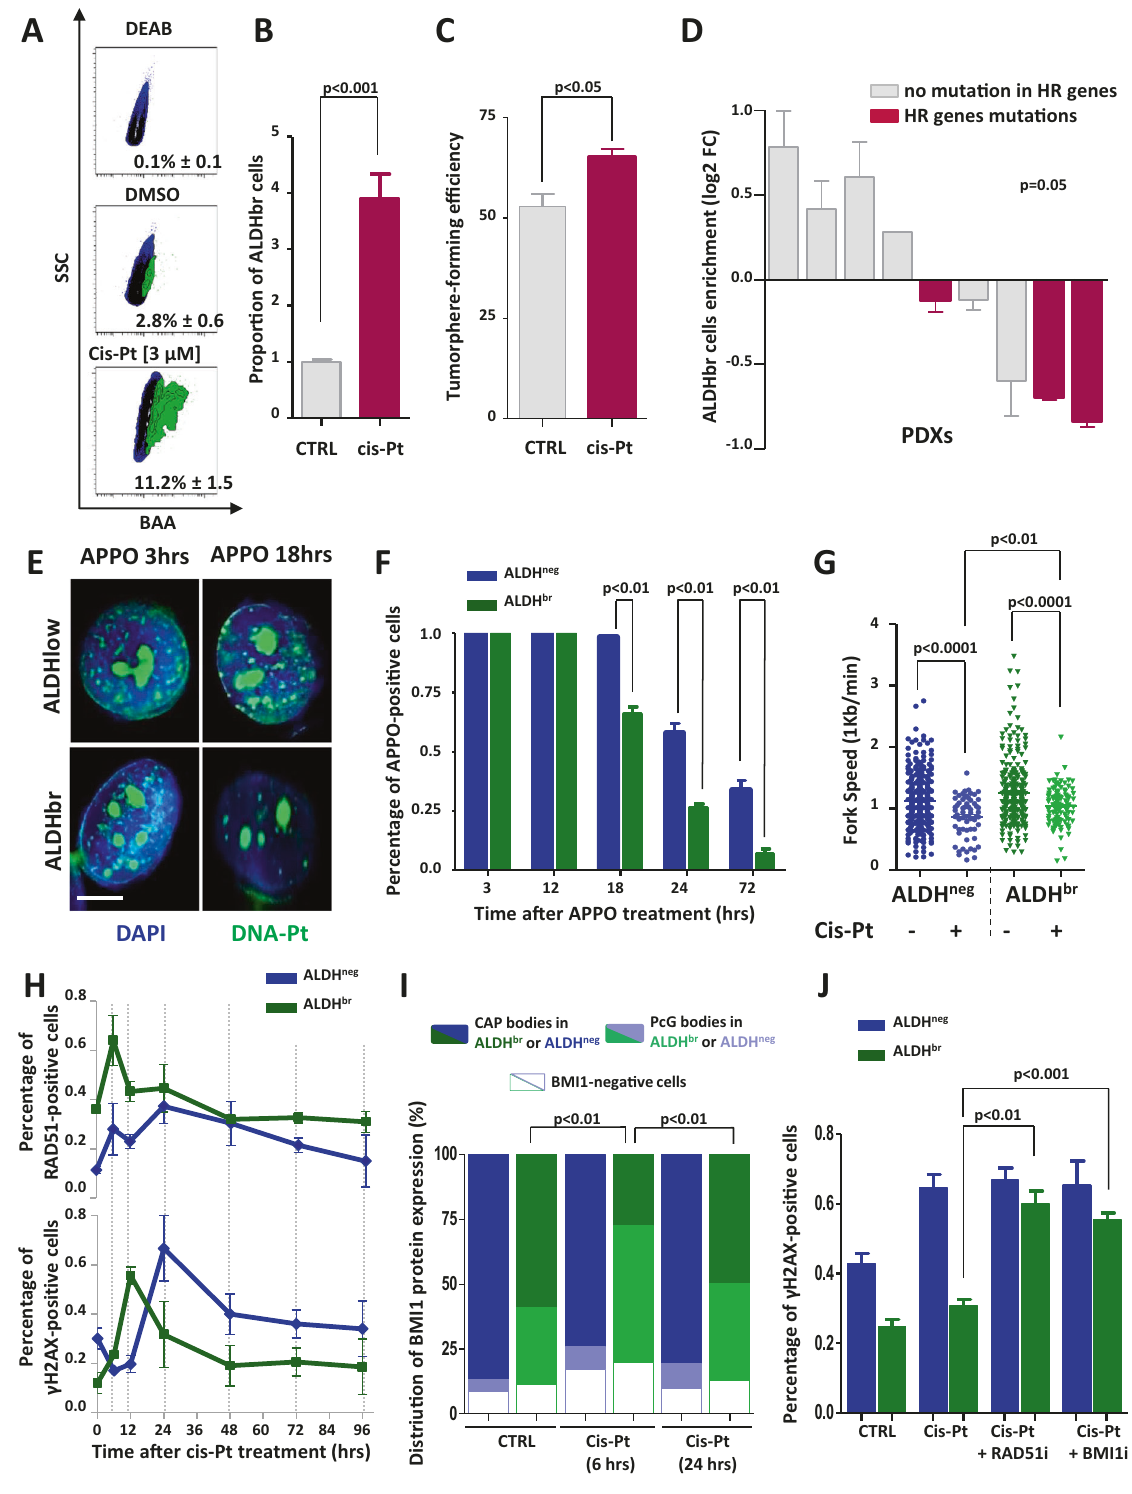
Tumosphere assay Cells were treated with drugs (using IC50) in adherent conditions for 72 h. Then, treated cells were plated in single ‐ cell suspension in 96 ‐ well ultra ‐ low-attachment plates, in a serum ‐ free mammary epithelium basal medium [6]. The frequency of cancer cells with tumorsphere ‐ forming potential was determined using the Extreme Limiting Dilution Analysis by plating cells at 25/10/5/3/2 and 1 cell per well ( n = 18 – 36 wells/condition).